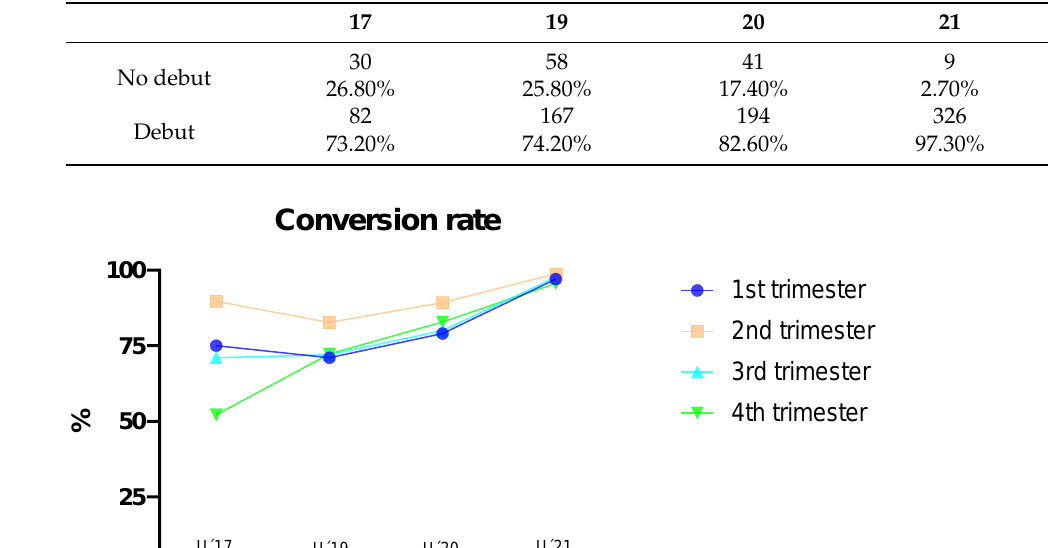
Figure 1. Players ’ careers across national teams.